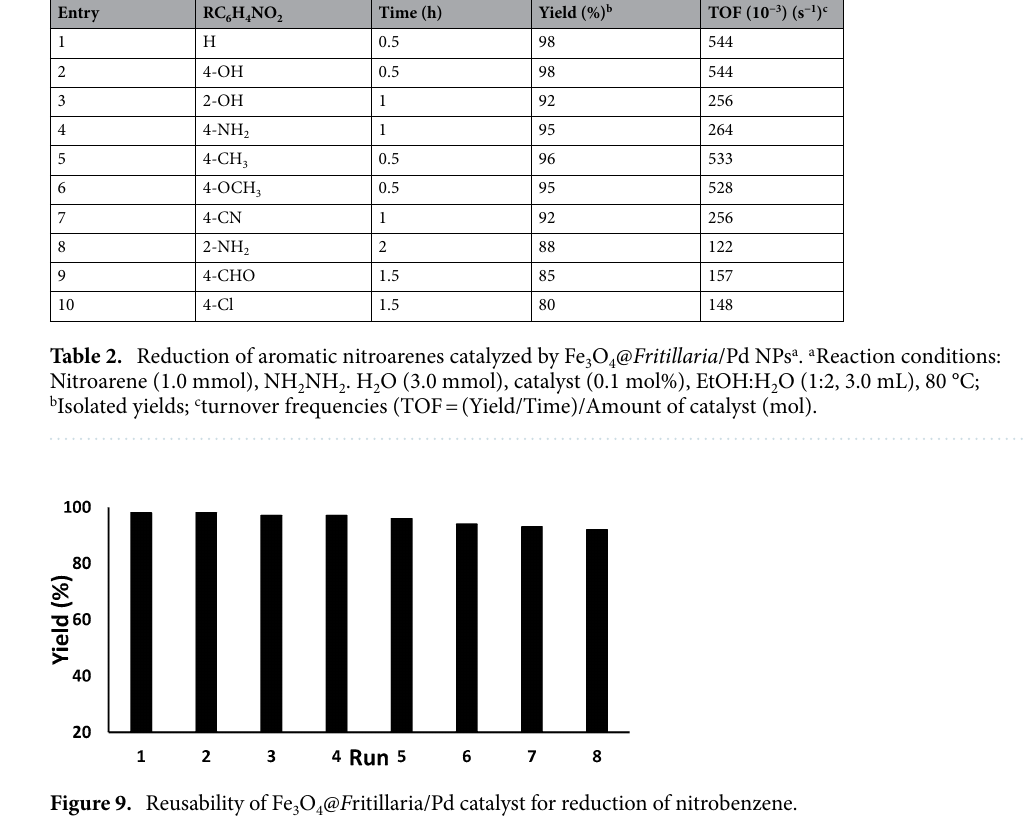
Figure 9. Reusability of Fe 3 O 4 @ F ritillaria/Pd catalyst for reduction of